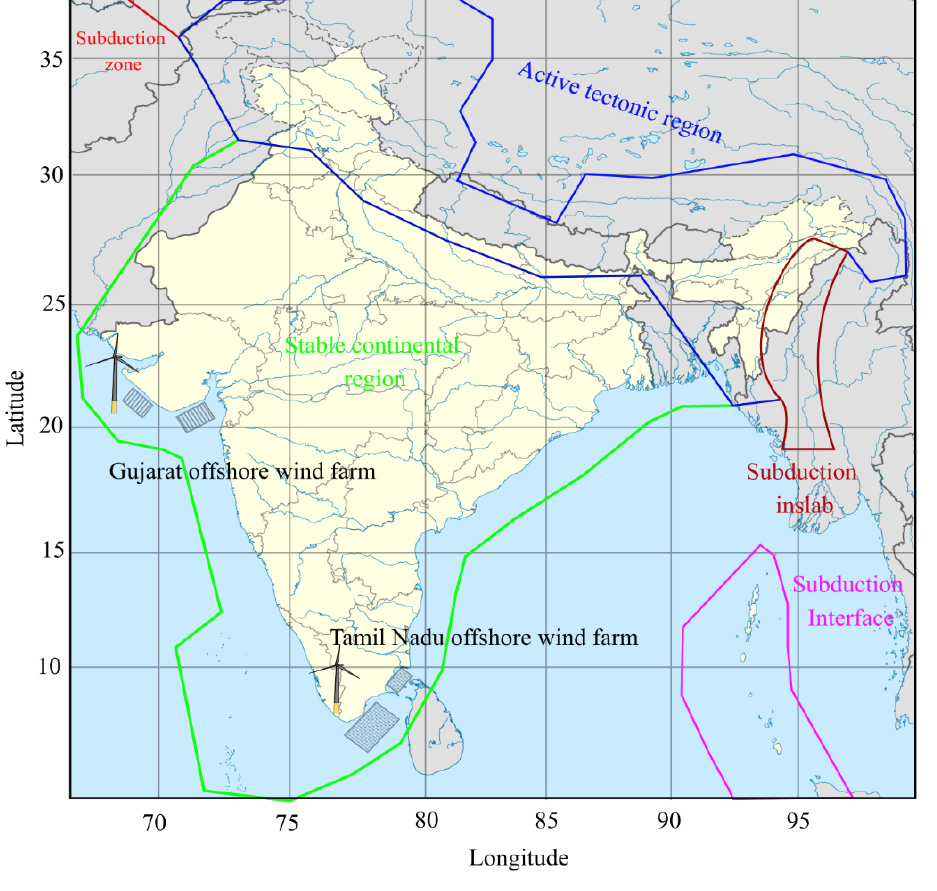
Figure A1. Major tectonic plates and potential offshore wind farm locations in India. Figure A2 shows the distribution of peak ground acceleration obtained for two return periods: 475 years (corresponding to a probability of exceedance of 10% in 50 years, shown in Figure A2a) and 285 years (corresponding to a probability of exceedance of 10% in 30 years, shown in Figure